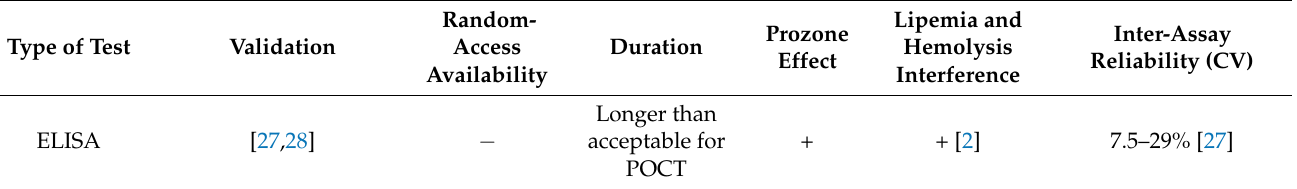
Table 2. A comparison of CRP assays validated in veterinary medicine. Abbreviations: POCT—Point of Care